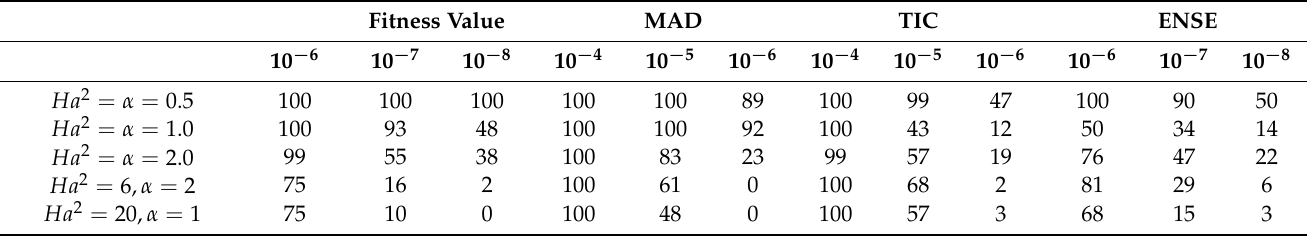
Table 6. Stability analysis in terms of fitness value, mean absolute deviations, Theil’s inequality coefficient, and error in Nash Sutcliffe efficiency of the design algorithm when executed for 100 multiple runs.